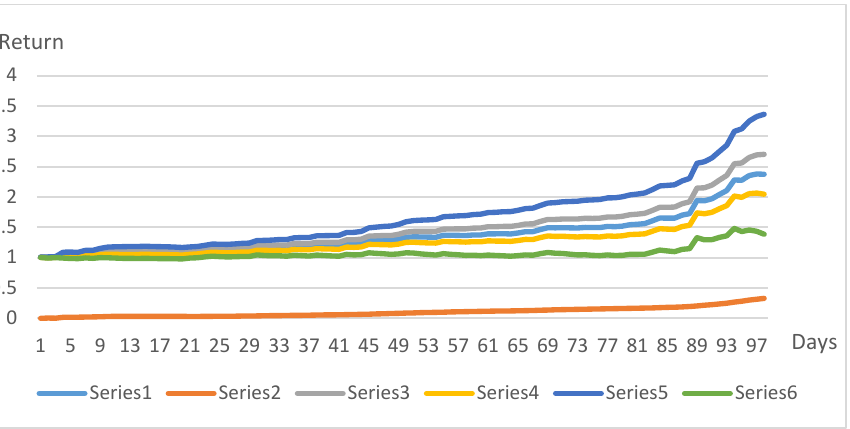
Figure 5. Confidence intervals of return on 30 stocks’ portfolio (US market) (source: compiled by the authors based on Yahoo Finance data and own calculations).